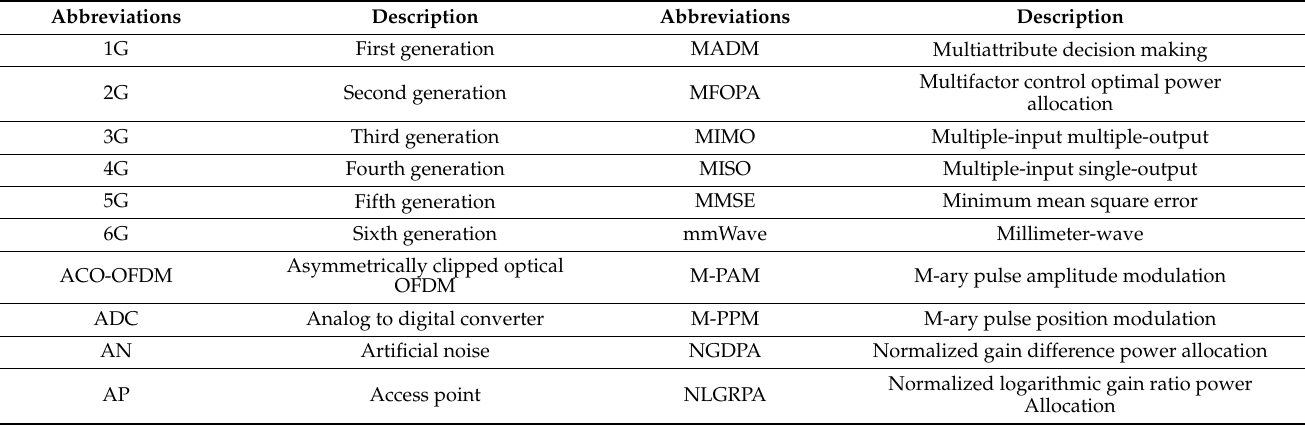
Figure 5. The structure of this paper. Table 1. List of